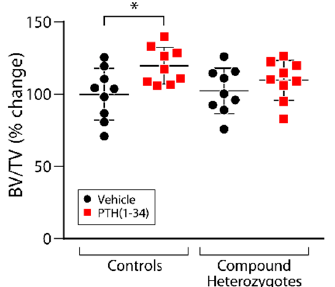
Figure 3. The osteoanabolic response to iPTH is inhibited in Naca / Lrp6 compound heterozygotes. Four-month-old female mice were treated once daily, 5 days/week for 1 month with 100 µ g/kg of PTH(1-34). Vertebrae were analyzed by µ CT. BV/TV, bone volume/tissue volume. Results are expressed as change from vehicle-treated animals, which are ascribed a value of 100%. * p < 0.05, two-way ANOVA with post hoc tests.